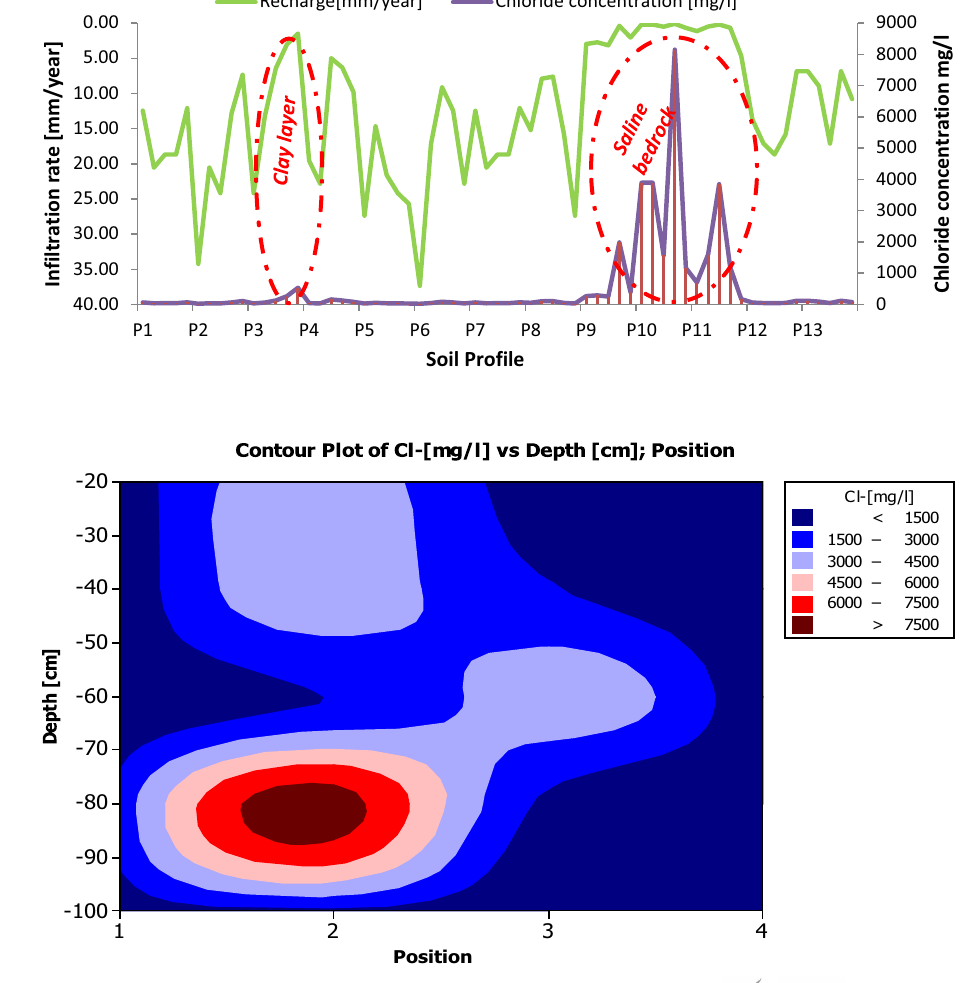
Fig. 5 Chloride concentration and groundwater recharge cal- culated for the 13 profiles (Ali Rahmani et al. 2017)